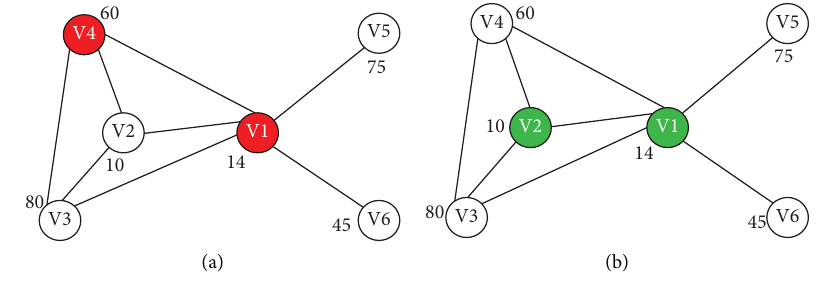
Figure 2: An example of a minimum weight dominating set.